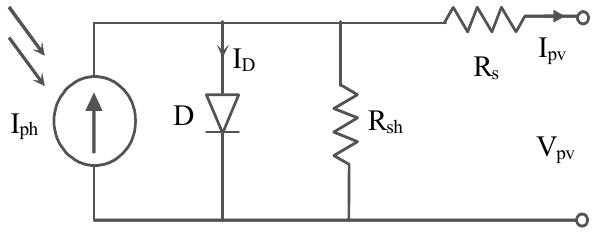
Figure 1. Equivalent circuit of a single-diode solar cell model.